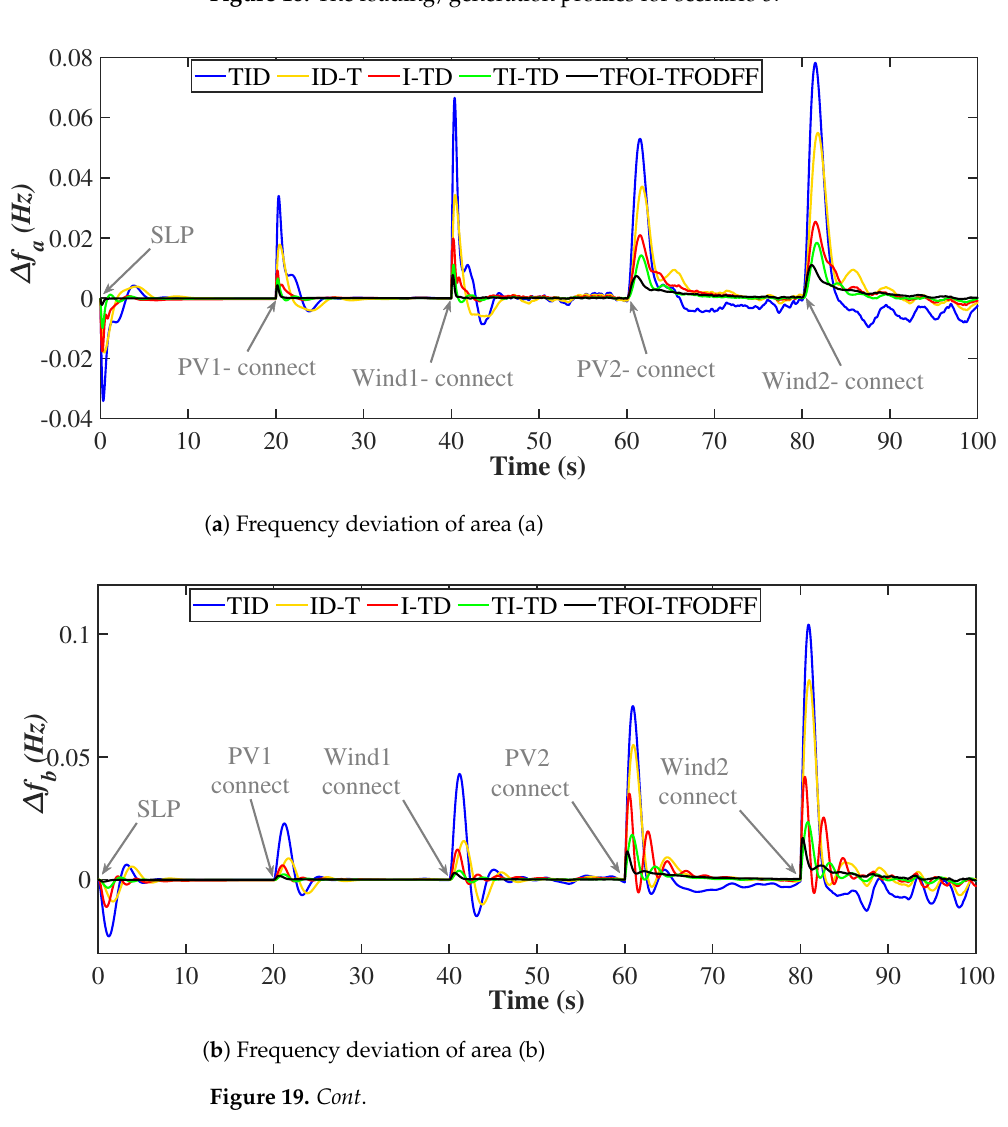
Figure 18. The loading/generation profiles for scenario 5.